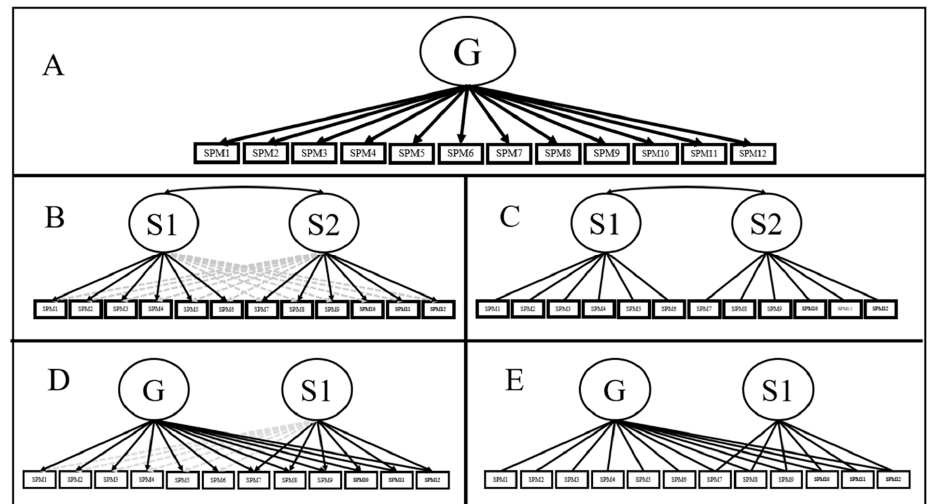
Figure 1. Schematic representation of theoretical SPM-LS models: ( a ): Unidimensional model; ( b ) Exploratory bi-dimensional model; ( c ): Confirmatory bi-dimensional model; ( d ): Exploratory bi-factor model; ( e ): Confirmatory bi-factor model. Arrows in black represent estimated paths for CFA models, and untargeted loadings in EFA models. Grey arrows represent targeted (minimised) loadings during EFA target rotation.